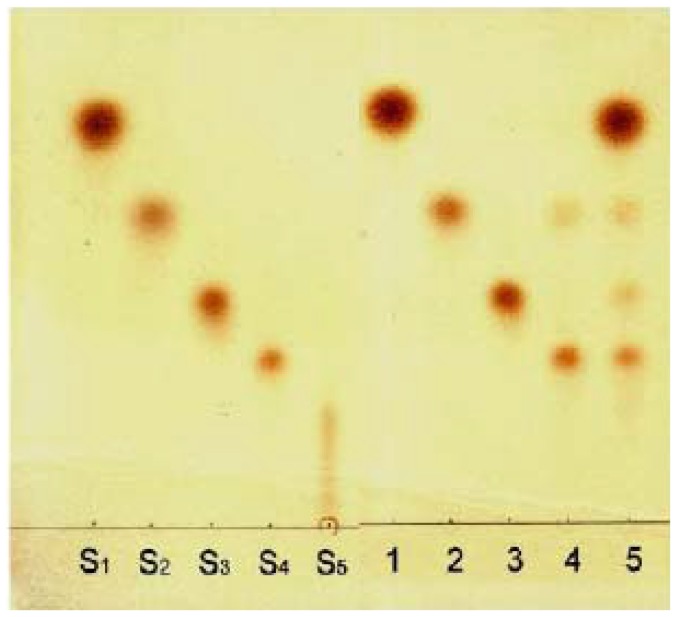
Thin-layer chromatogram showing hydrolysis of chitin oligomers (GlcNAc2–5) by the purified chitinase from black soybean seeds.Lanes S1 through S5 indicate standard N-acetylglucosamine monomer and oligomers GlcNAc, GlcNAc2, GlcNAc3, GlcNAc4 and GlcNAc5, respectively. Lanes 1 through 5 indicate hydrolysis products of N-acetylglucosamine oligomers from monomer to pentamer respectively.